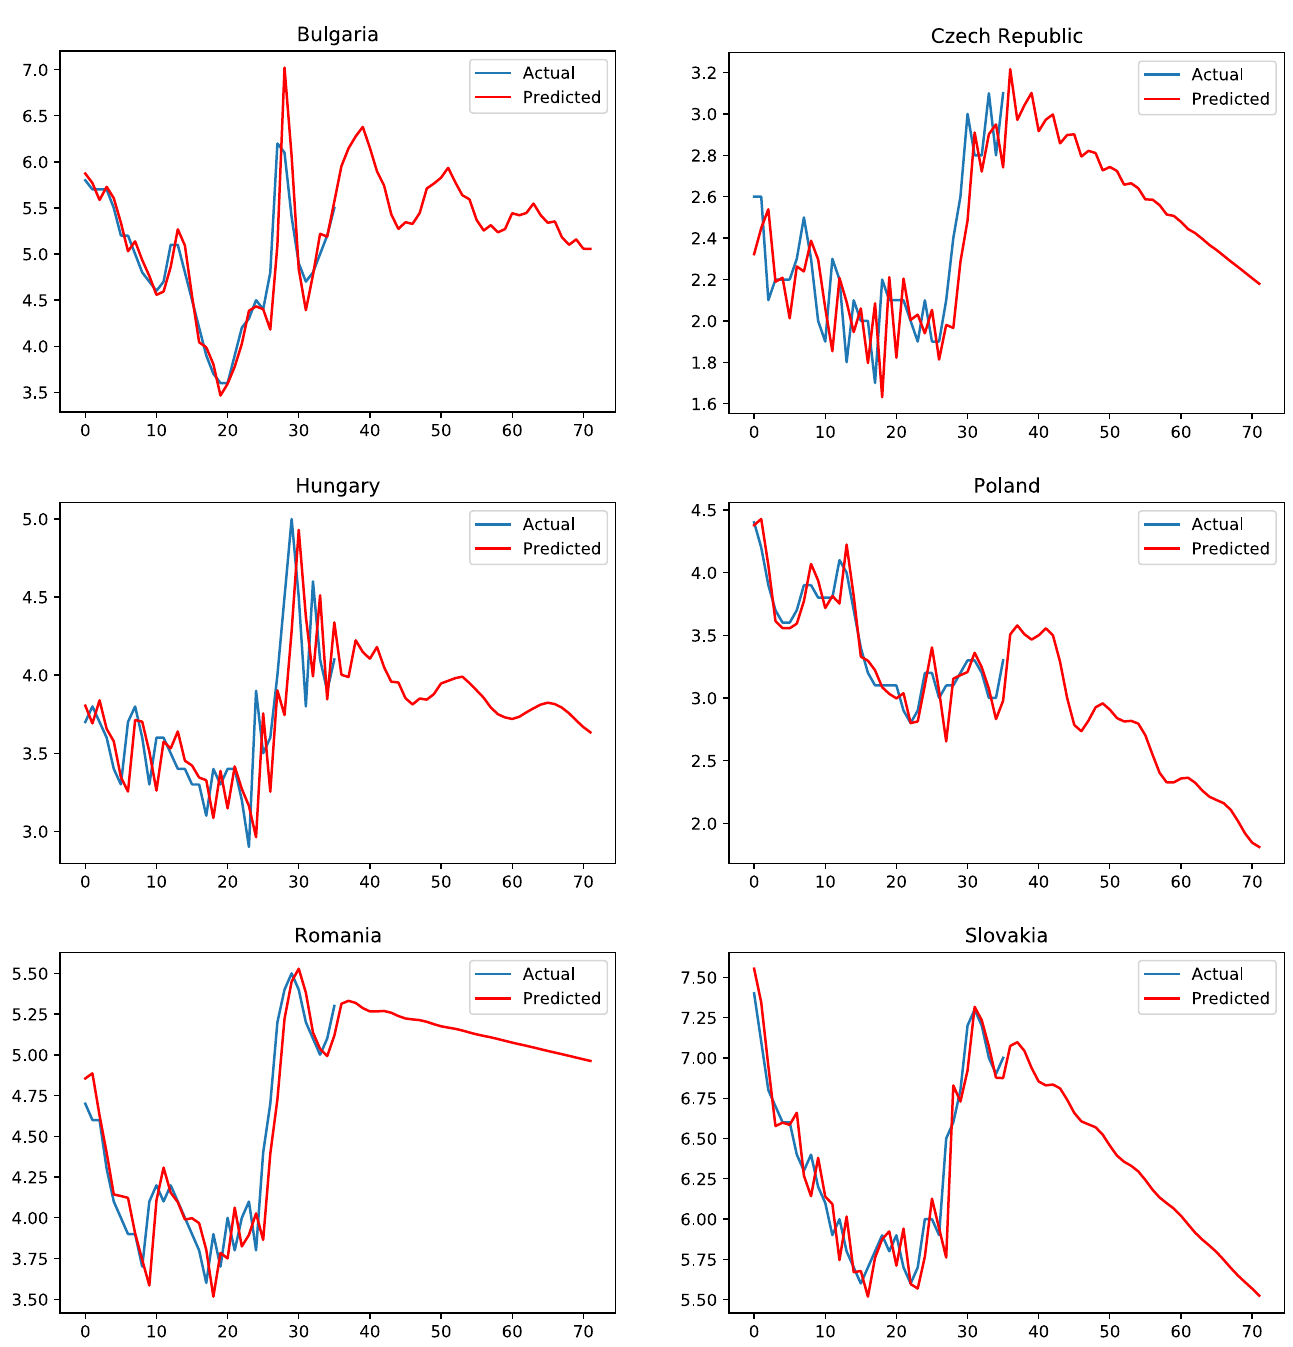
Figure 8. Test data predictions and 3 years ahead forecasts (unemployment rates in months). From Figure 9, one can notice that there is a positive slope between PRPSE and UR, meaning that there is a positive linear correspondence for all six countries, while in Figure 10 one can notice a negative slope between SPLS and UR, which means there is a negative linear relationship for Czechia, Poland, Romania and Slovakia but it is less clear for Bulgaria and Hungary. For those countries where the relation is significant, as the UR increases, the PRPSE also increases and the SPLS